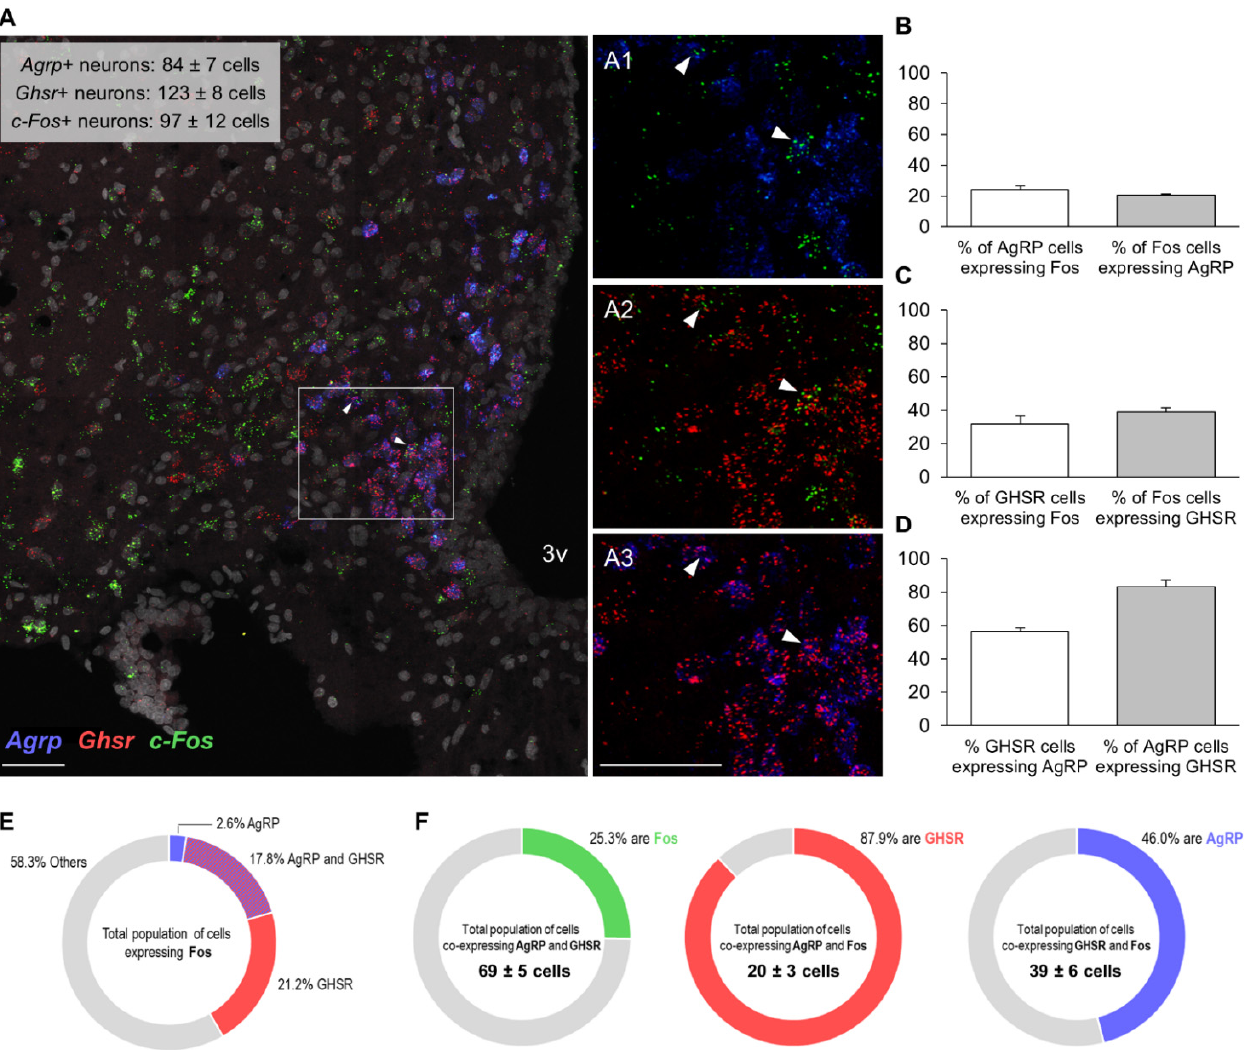
Figure 4. Colocalization of mRNAs for Fos protein, GHSR and AgRP in the Arc of non-food-deprived PB taste-familiar rats exposed to the olfactory PB cue. ( A ) Representative confocal images of triple RNAscope in situ hybridization for c-Fos (green), Ghsr (red) and Agrp (blue) in an Arc-containing section of a PB taste-familiar rat exposed to the olfactory PB cue. Area in the white rectangle is shown enlarged in the small panels on the right ( A1 – A3 ); colocalization of mRNAs for ( A1 ) Fos protein and AgRP; ( A2 ) Fos protein and GHSR; and ( A3 ) GHSR and AgRP. White arrows indicate triple positive cells. The graphs depict ( B ) % of AgRP cells that are Fos+, and the % of Fos cells that are AgRP+; ( C ) % of GHSR cells that are Fos+, and the % of Fos cells that are GHSR+; ( D ) % of GHSR cells that are AgRP+, and the % of AgRP cells that are GHSR+ (Data are represented as mean ± SEM). ( E ) Overview of the molecular identities of Fos+ cells; ( F ) triple colocalization data. 3v, third ventricle. Bregma: − 2.64 mm; Scale bar = 50 μ m (applies to all four images). Two–four hemisections per rat were quantified ( n = 4).